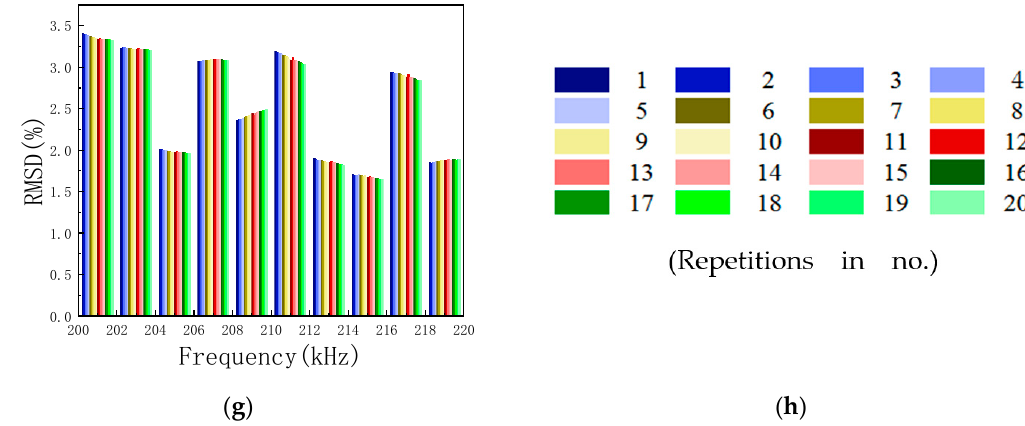
Figure 13. The RMSD values of ten sub-frequency bands at different torque levels for twenty repeated experiments ( a ) 2.5 lb·ft, ( b ) 5.0 lb·ft, ( c ) 7.5 lb·ft, ( d ) 10.0 lb·ft, ( e ) 12.5 lb·ft, ( f ) 15.0 lb·ft, ( g ) 17.5 lb·ft, ( h ) Repetitions (in No.).